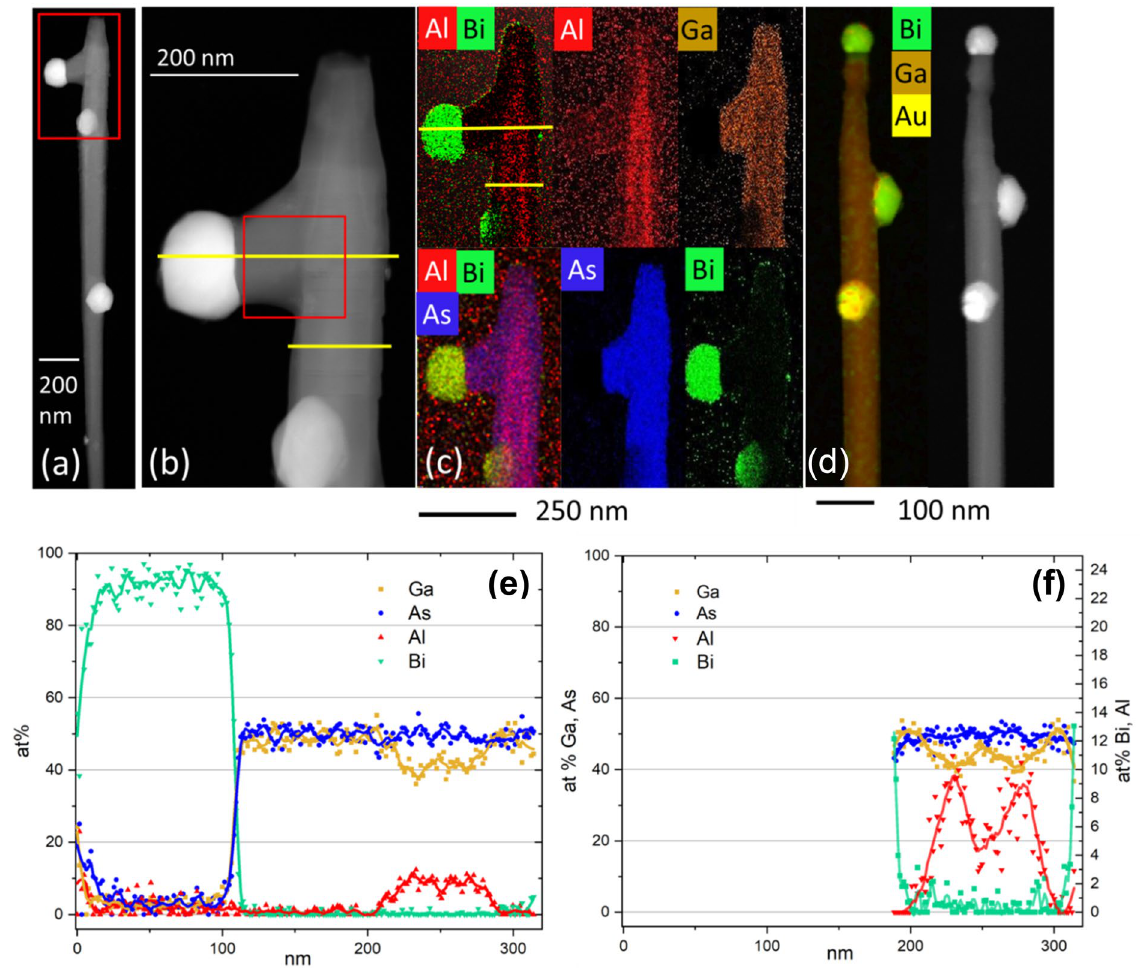
Figure 4. ( a , b ) TEM images of the upper GaAs-(Ga,Al)As-Ga(As,Bi) core-double shell NW part with Bi-catalyzed side branch (the very top part with the top catalyzing droplet has been broken during the NW collection), the side Bi droplet catalyzes the branch growth; ( c ) EDS composition maps visualizing the distribution of the elements: Ga, Al, As, Bi in the NW section shown in ( b ); ( d )—EDS composition map of another NW picked from Sample 3, showing Au droplet, which slid downwards and was replaced by the Bi droplet at the NW top; ( e , f )—EDS line scans showing the distribution of the elements along yellow lines marked in ( b , c